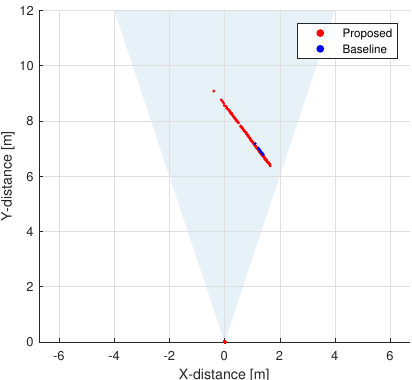
Figure 5. Long range detection, xy-plot with the baseline (blue) and the proposed method (green). The target is a straight brick Figure 4. Long range detection, visualization of one measurement wall shown in a green box in Figure 1. Only the observations that sample from each channel with (a) baseline and (b) the proposed have at least 50% repeatability are shown. This is the follow-up ∈ S b , versus the baseline method. (c) Supported ranges, r i result from Figure 4 for range n ranges. The target is a straight brick wall shown in a green box in Figure 1, measurement B data.